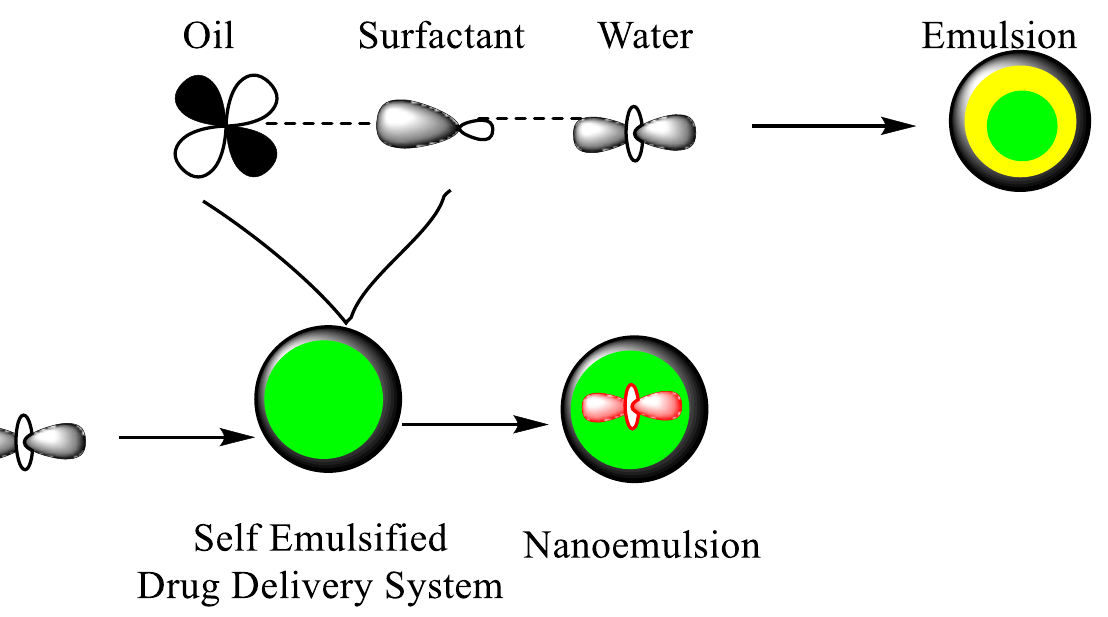
Figure 1. Pictorial representation of a self-emulsified drug delivery system and nanoemulsion.